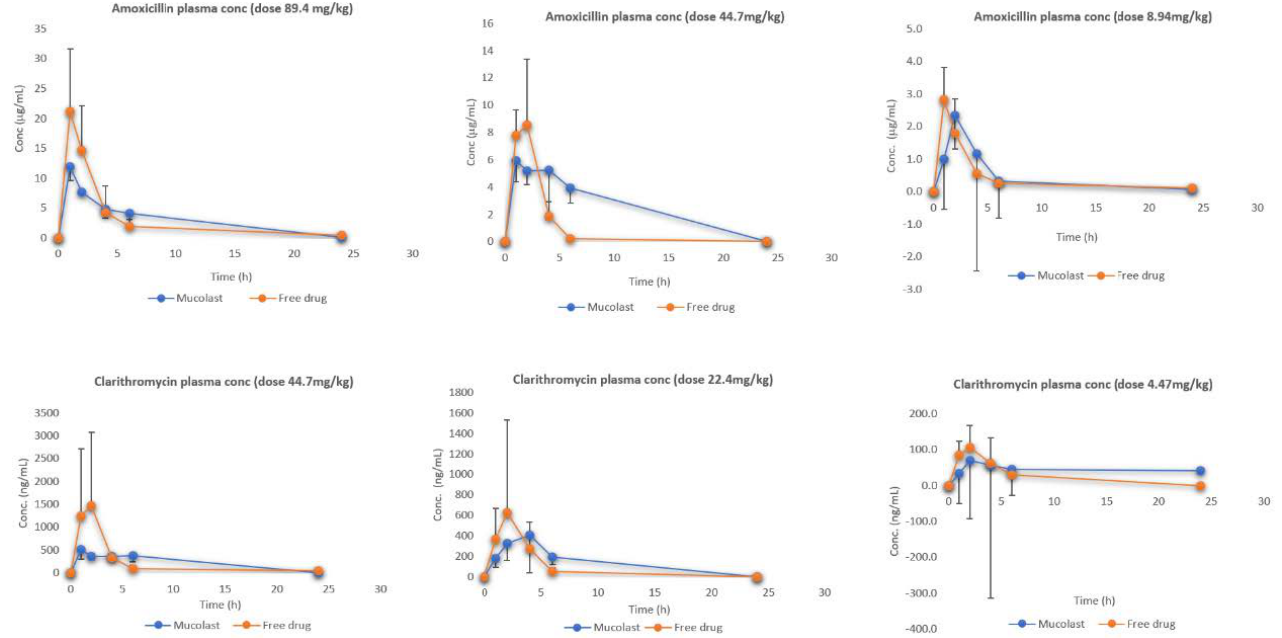
Figure 2. Amox and Clar plasma levels after the administration of antibiotics in Mucolast ® or PBS solution at three different doses.